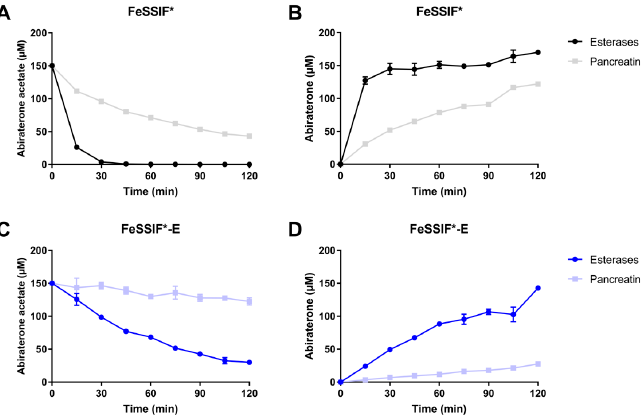
Figure 3. Concentration ‐ time profile of the degradation study of abiraterone acetate in ( A , B ) FeSSIF* and ( C , D ) FeSSIF* ‐ E supplemented with porcine esterases (80 IU/mL) or porcine pancreatin extract (0.83 mg/mL) after the addition of 150 μ M abiraterone acetate and the corresponding formation of and ( C , D ) FeSSIF*-E supplemented with porcine esterases (80 IU/mL) or porcine pancreatin extract abiraterone ( B , D ). Results are expressed as mean ± SD (n = 3). (0.83 mg/mL) after the addition of 150 µ M abiraterone acetate and the corresponding formation of abiraterone ( B , D ). Results are expressed as mean ± SD (n =